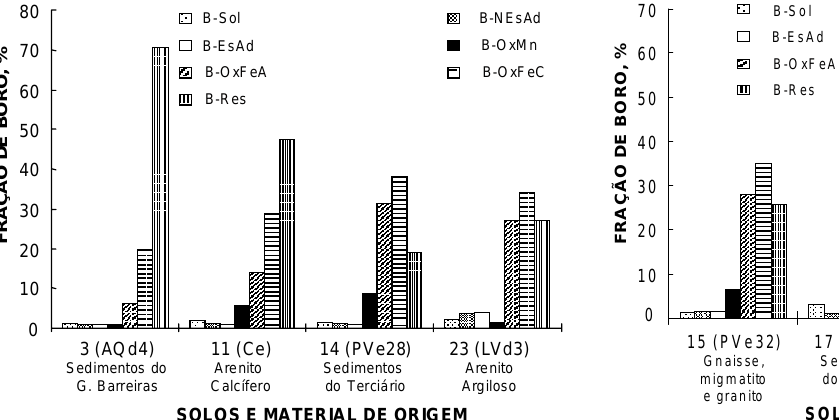
Figura 1. Distribuição percentual das frações de boro em quatro classes de solos de diferentes materiais de origem.